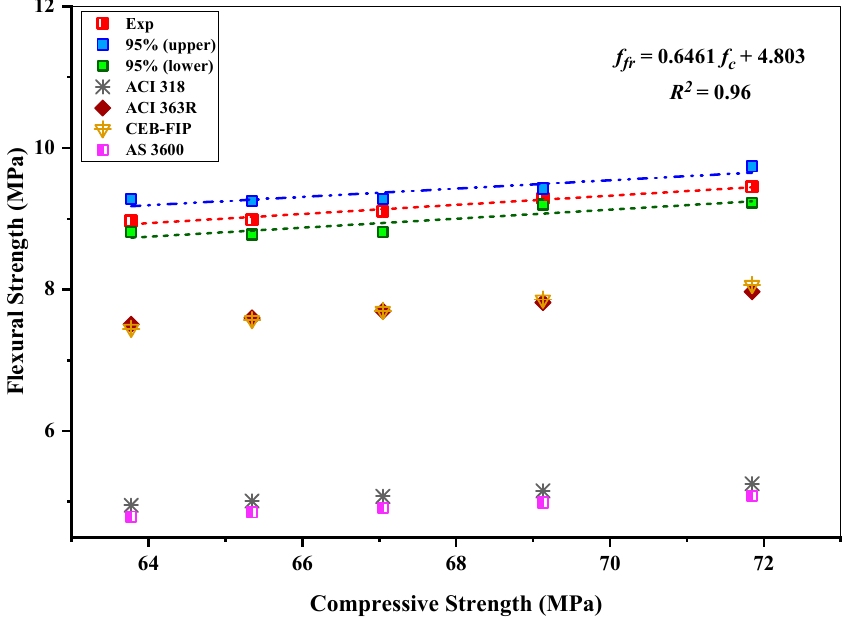
Figure 16. Relationship between the compressive strength and flexural strength of RHA-incorporated concrete mixes.